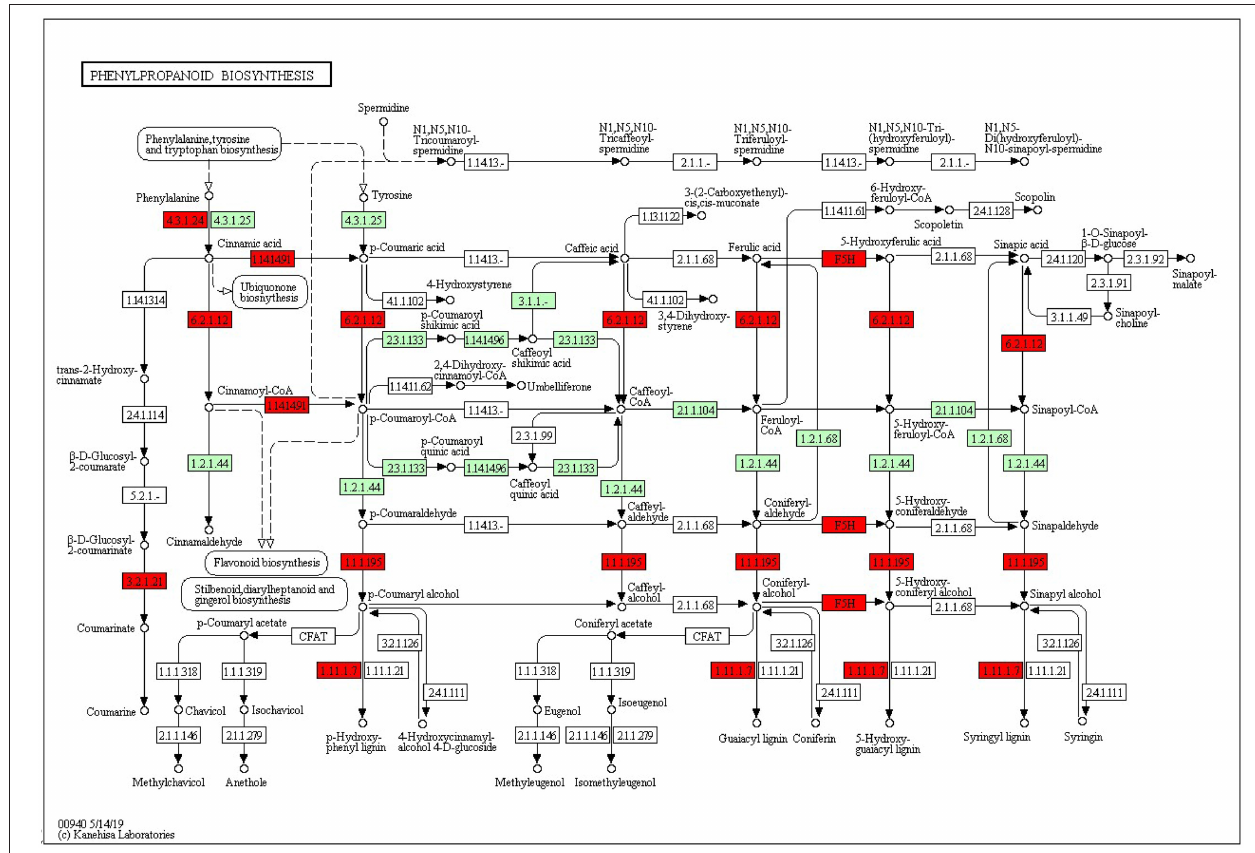
FIGURE 6 | Phenylpropanoid biosynthesis pathway. (4.3.1.24) Phenylalanine ammonia-lyase. (1.14.14.91) Cytochrome P450 CYP73A100. (F5H) Cytochrome P450 84A1. (3.2.1.21) Beta-glucosidase 1. (1.1.1.195) Cinnamyl alcohol dehydrogenase 2. (1.11.1.7) Peroxidase 70-like. Red color represents significant and characterized enzymes based on Oryza sativa annotation. Green color represents significant and non-characterized enzymes. White color represents characterized enzymes based on Arabidopsis thaliana